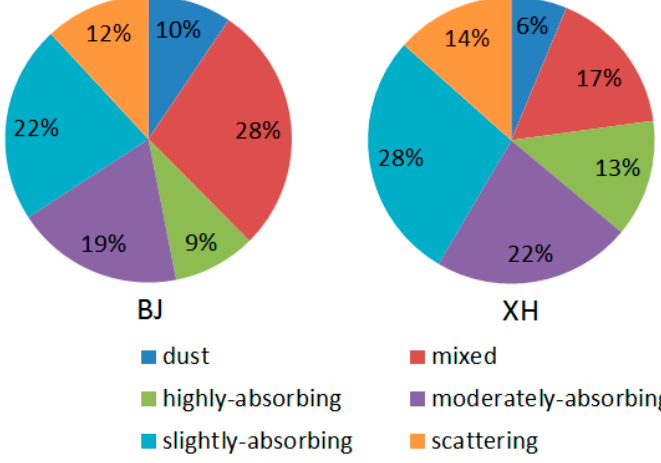
Figure 7. Distribution of different aerosol types at BJ and XH sites.